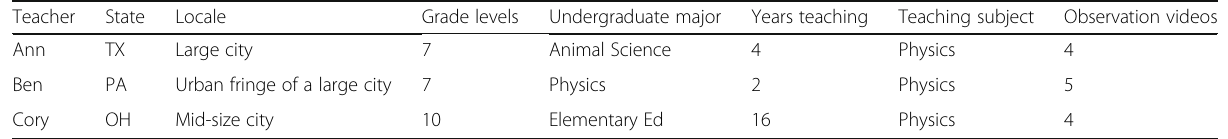
Table 3 Participant information